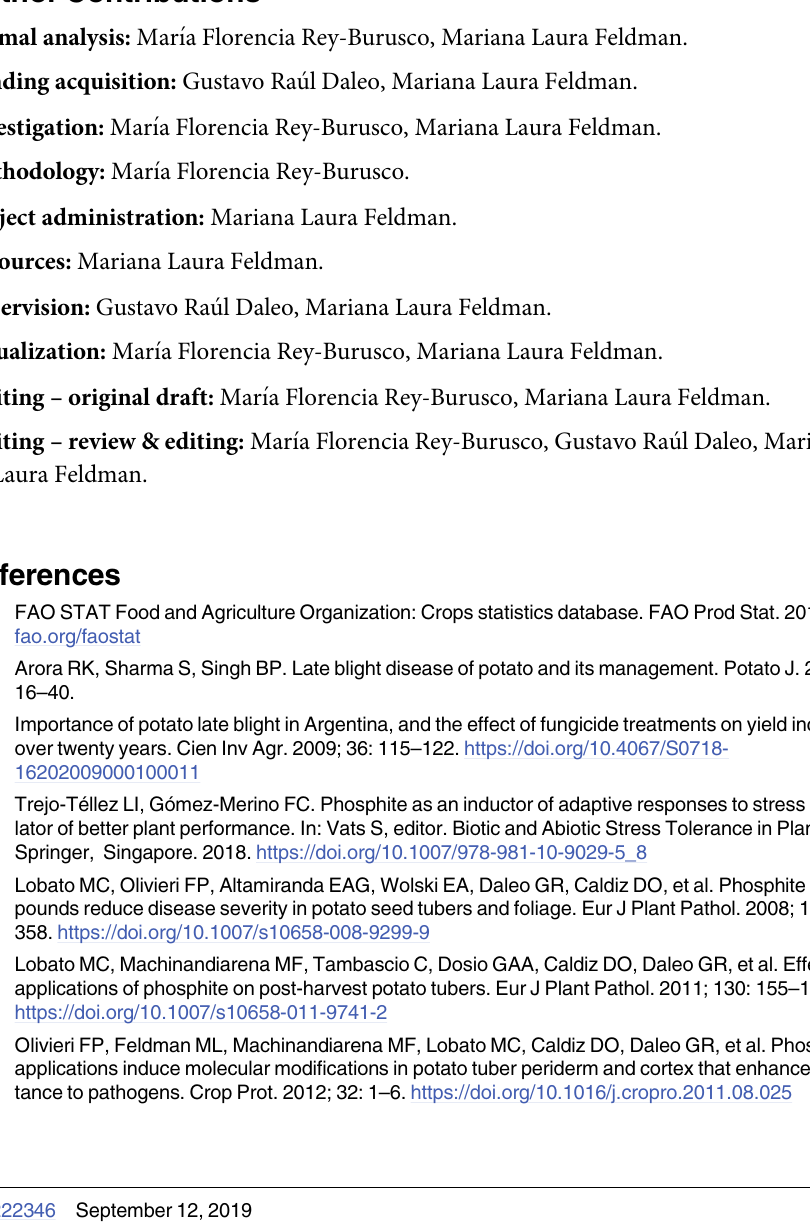
S3 Table. miRNAs differential expression. S4 Table. Target prediction. S5 Table. GO